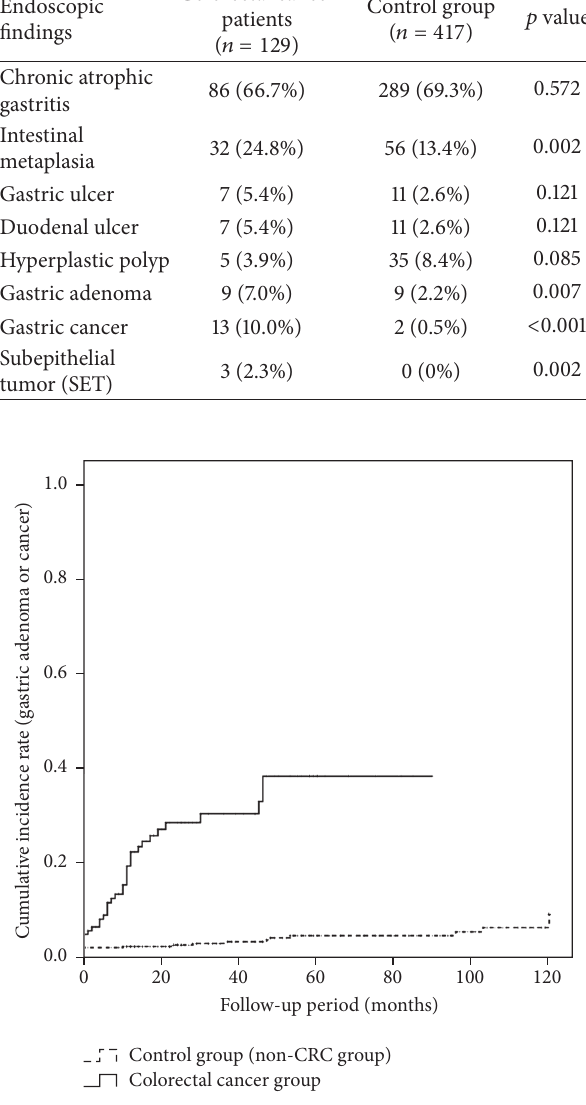
Figure 2: Cumulative Incidence Rate of Gastric Adenoma or Cancer in Colorectal Cancer Patients Group and Control Group. The cumulative incidence rate was higher in the colorectal cancer patients group than in the control group over the follow-up period ( 𝑝 < 0.001 ). Gastric adenoma or cancer mostly developed during the first 2 years of follow-up and as late as 4 years after